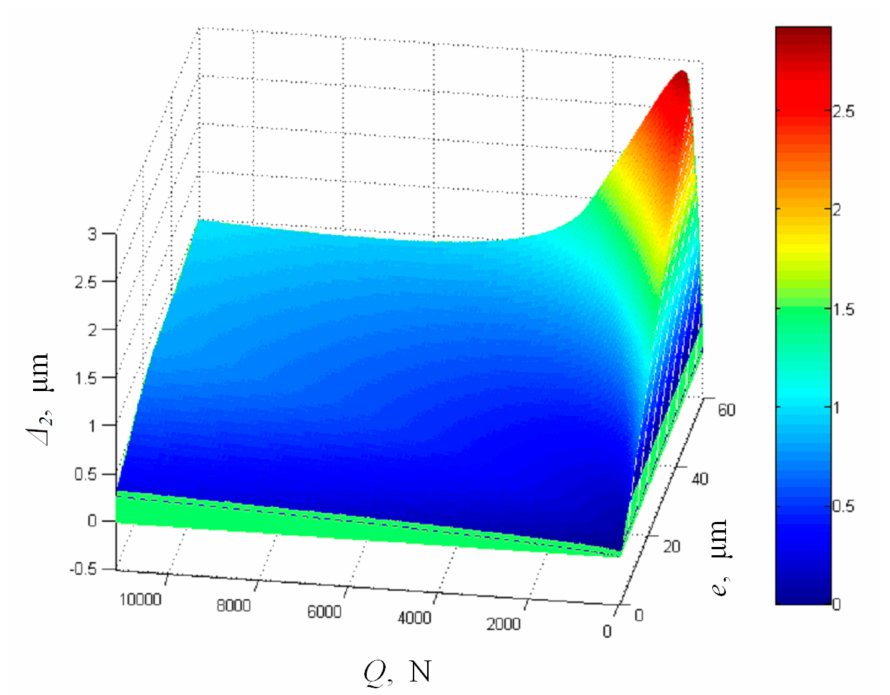
Figure 8. Three-dimensional dependence of vibration amplitude due to contact deformations ( ∆ 2 ) on the size of internal radial clearance ( e ) and level of external load ( Q ) for the 6206-single-row ball